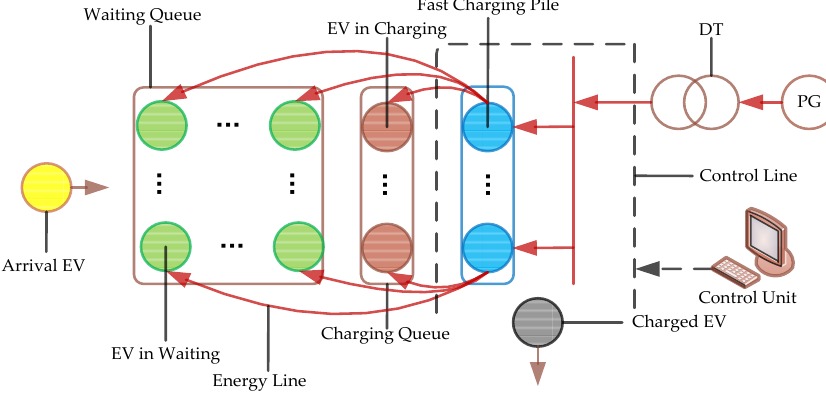
Figure 1. Charging infrastructure system structure of the new quick charging station (CS).